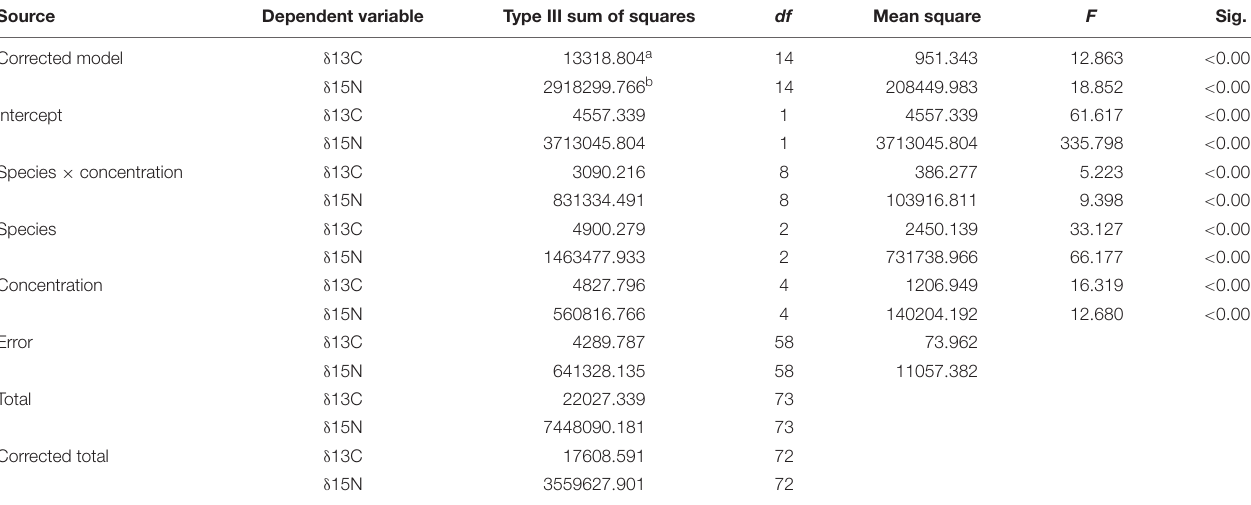
TABLE 4 | Two-way ANOVA table analyzing the δ 13 C and δ 15 N isotope values of three different bivalve species studied ( Crassostrea virginica , Ischadium recurvum , and Mercenaria mercenaria ) at each brown tide concentration. Source Dependent variable